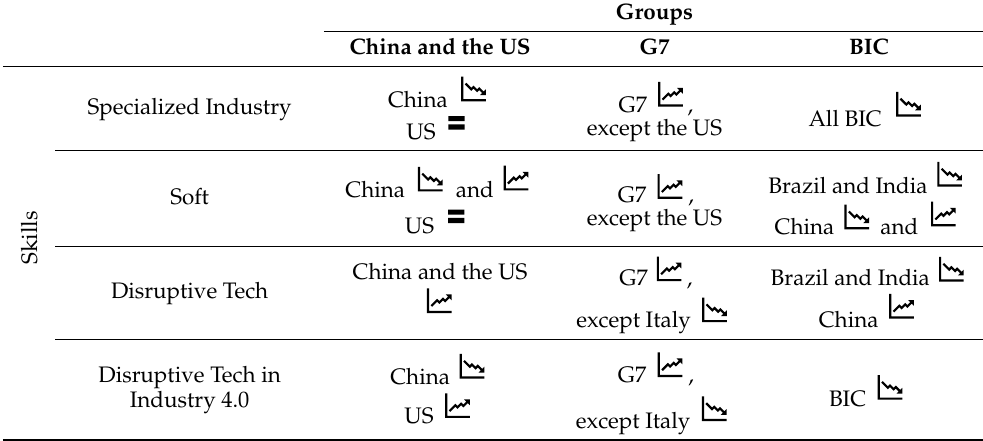
Table 2. Summary of the skills migration trend analysis. Groups